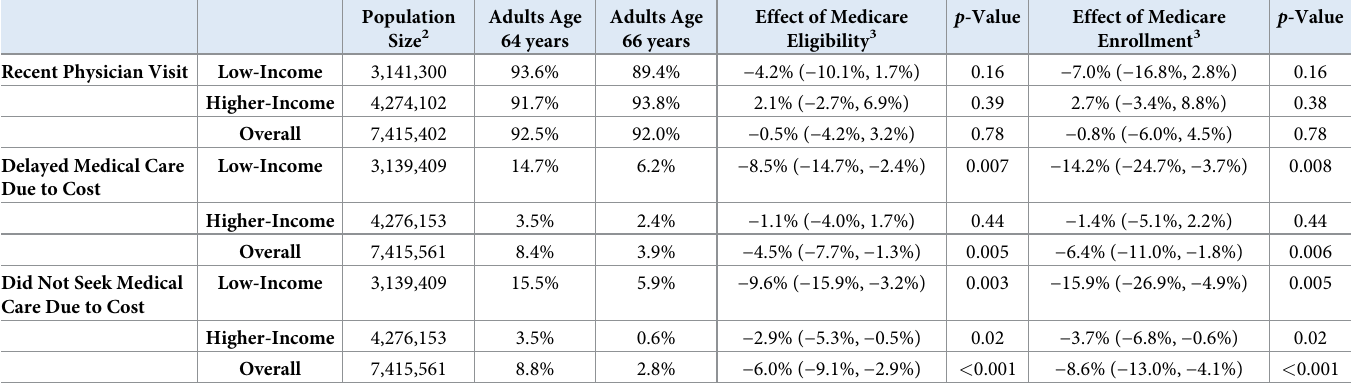
Table 2. Association of Medicare eligibility and enrollment with healthcare access by income level 1